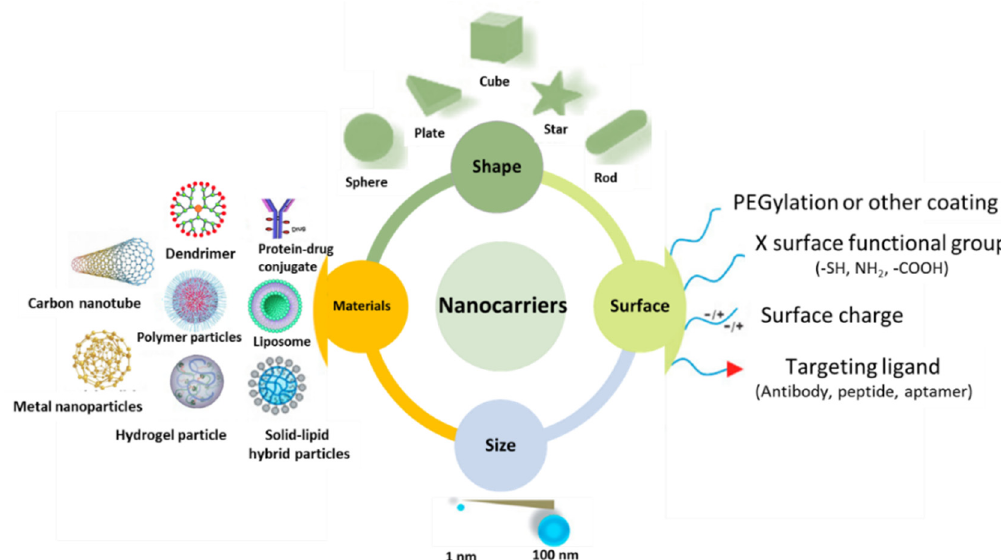
Figure 1. Nanocarriers for drug delivery and their biophysiochemical properties. Many factors are involving in determining their therapeutic potential including size, shape, materials, and surface chemistry.